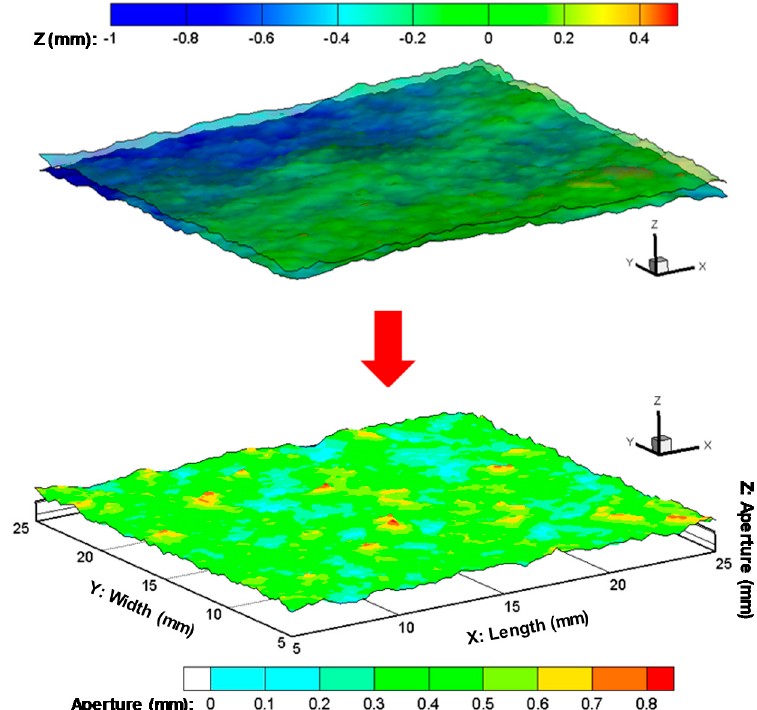
Figure 2. Generation of the original self-affine fracture with the upper surface displaced from the lower surface.